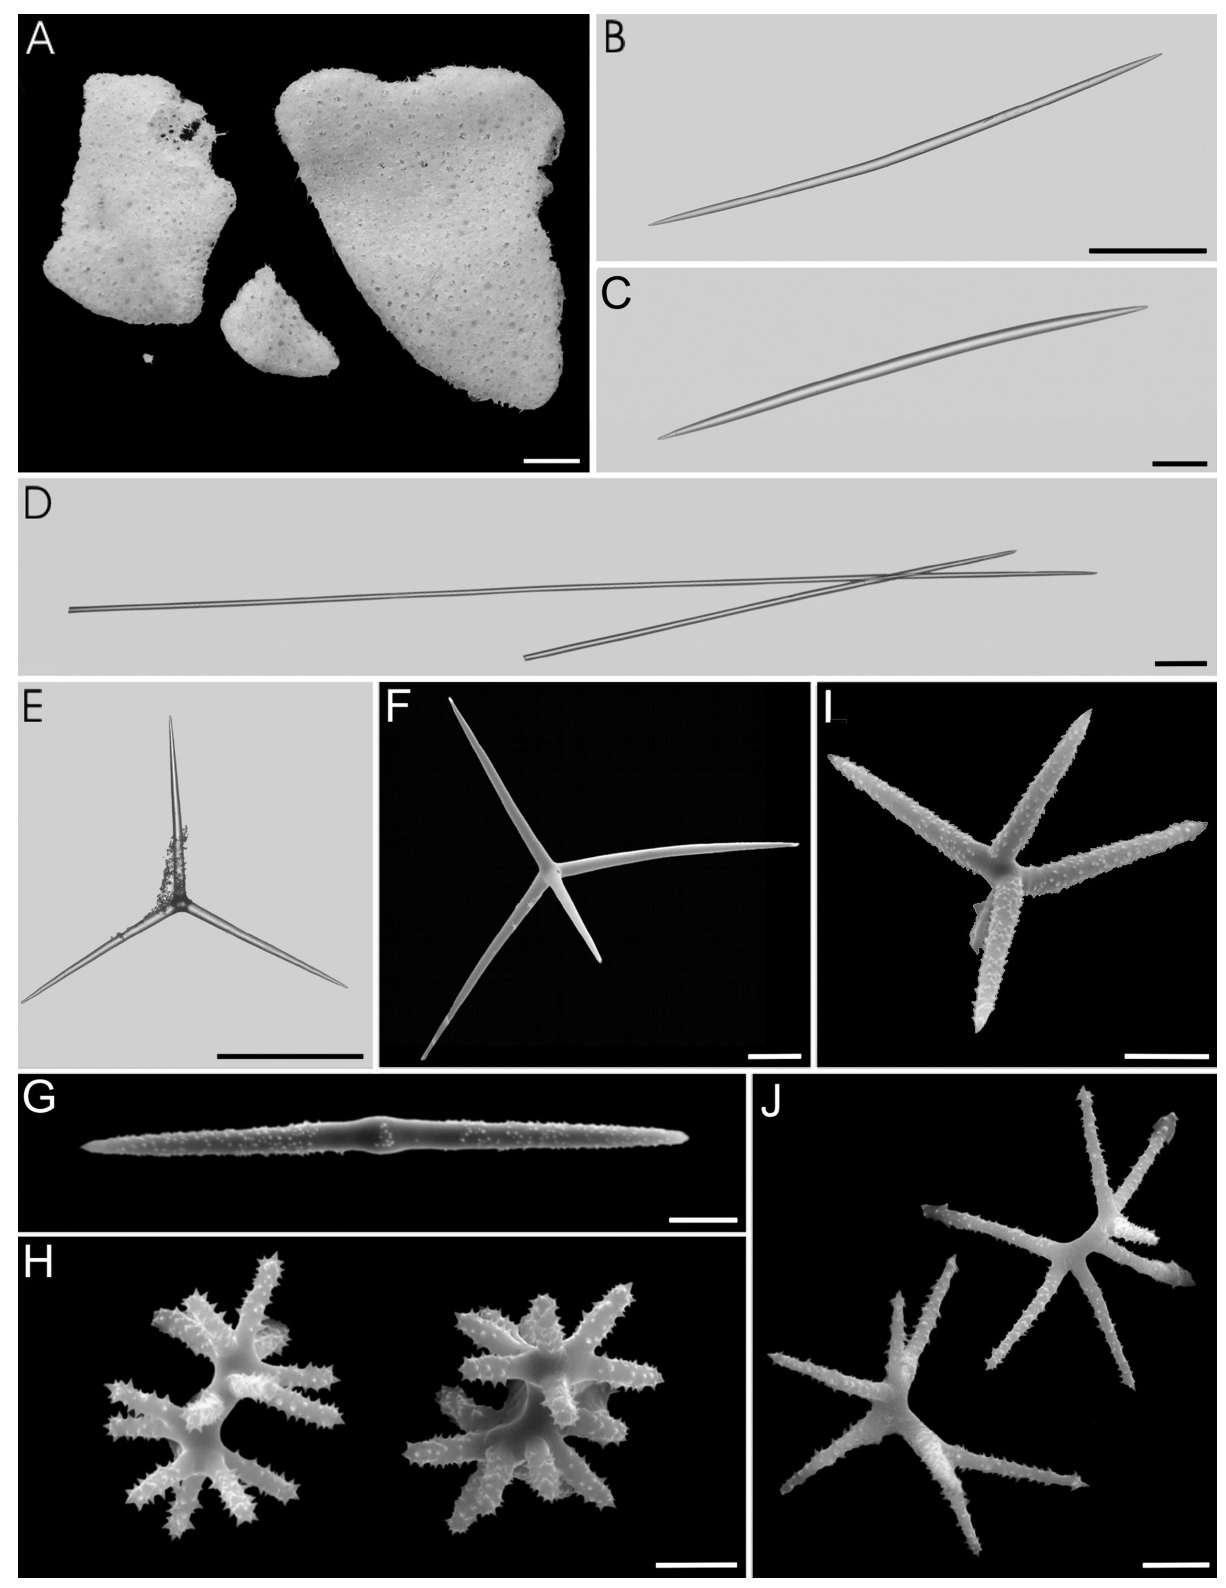
Fig . 3. – Poecillastra maremontana n. sp. A, schizotype (MNRJ 12563). B, Oxea I. C, Oxea II. D, Oxea III (broken). E-F, Calthrops. G, Acanthomicroxea. H, Spirasters. I, Plesiaster I. J, Plesiasters II (metasters). Scale: A, 1 cm; B, 500 µm; C-F, 100 µm; G, I, 10 µm; H, J, 5